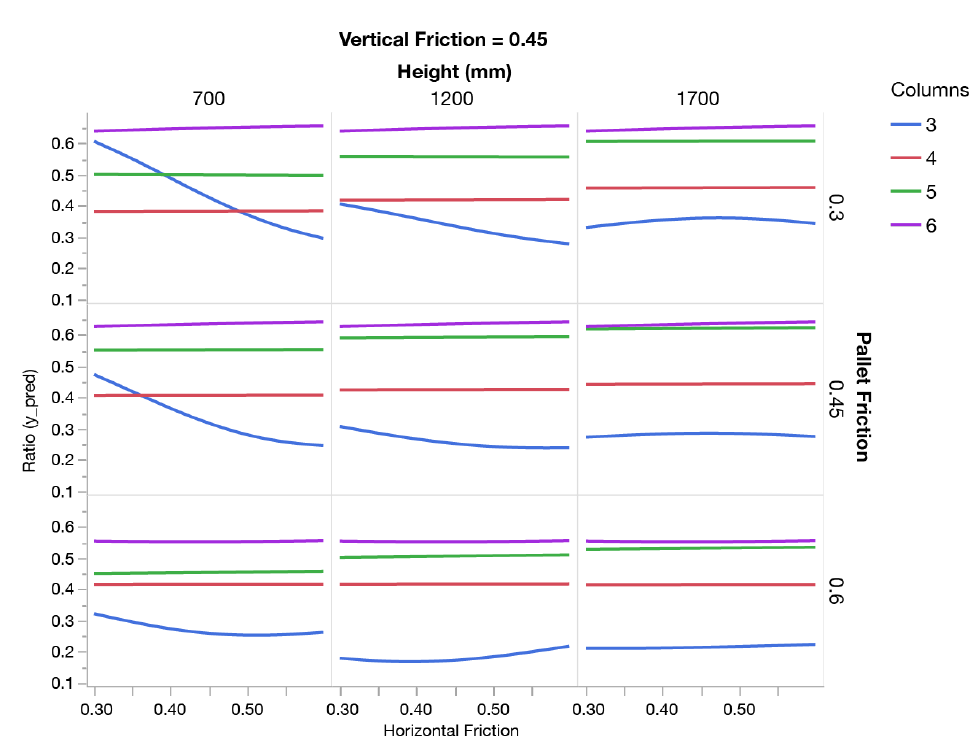
Figure 14. Effect of the friction coefficient of the vertical surface of the packages on board bending ratio by pallet friction, payload height (mm), and number of columns, with a fixed coefficient of friction of the horizontal surface of 0.45.